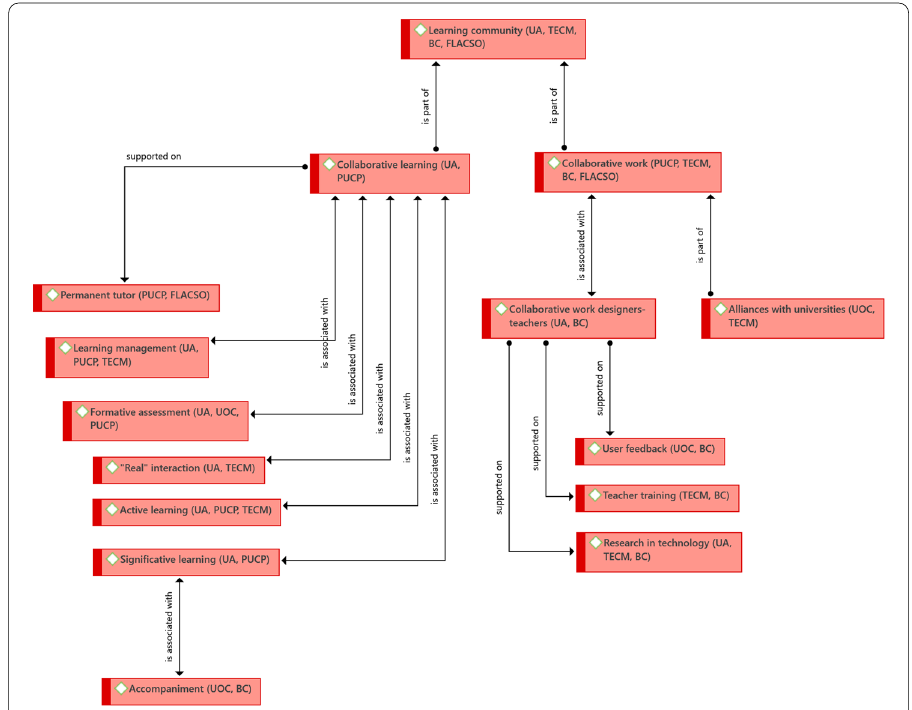
Fig. 4 Structure of driving ideas that are shared key factors from the educational dimension. Source: Diógenes